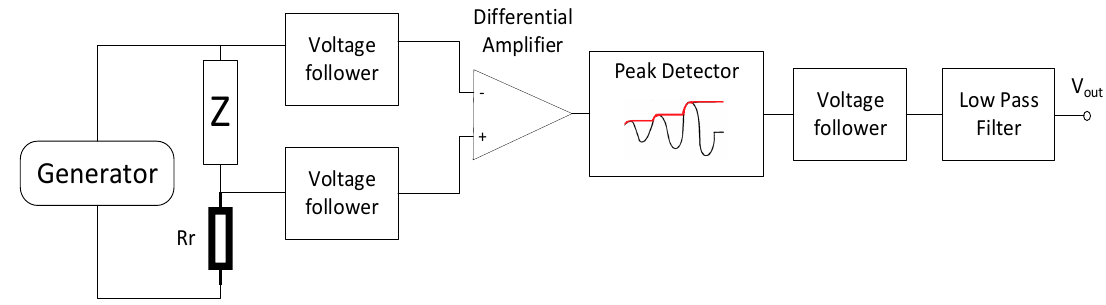
Figure 6. Block diagram of the operation of the impedance measurement Figure 6 . Block diagram of the operation of the impedance measurement block. Figure 6 . Block diagram of the operation of the impedance measurement block.